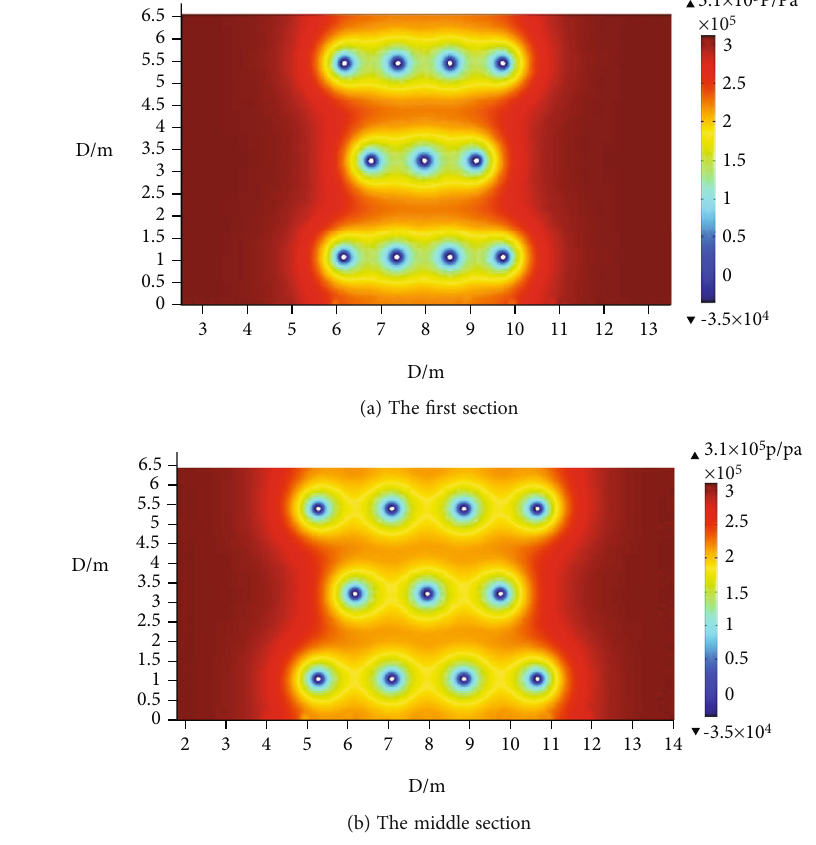
Figure 5: The gas pressure cloud diagram from simulation.